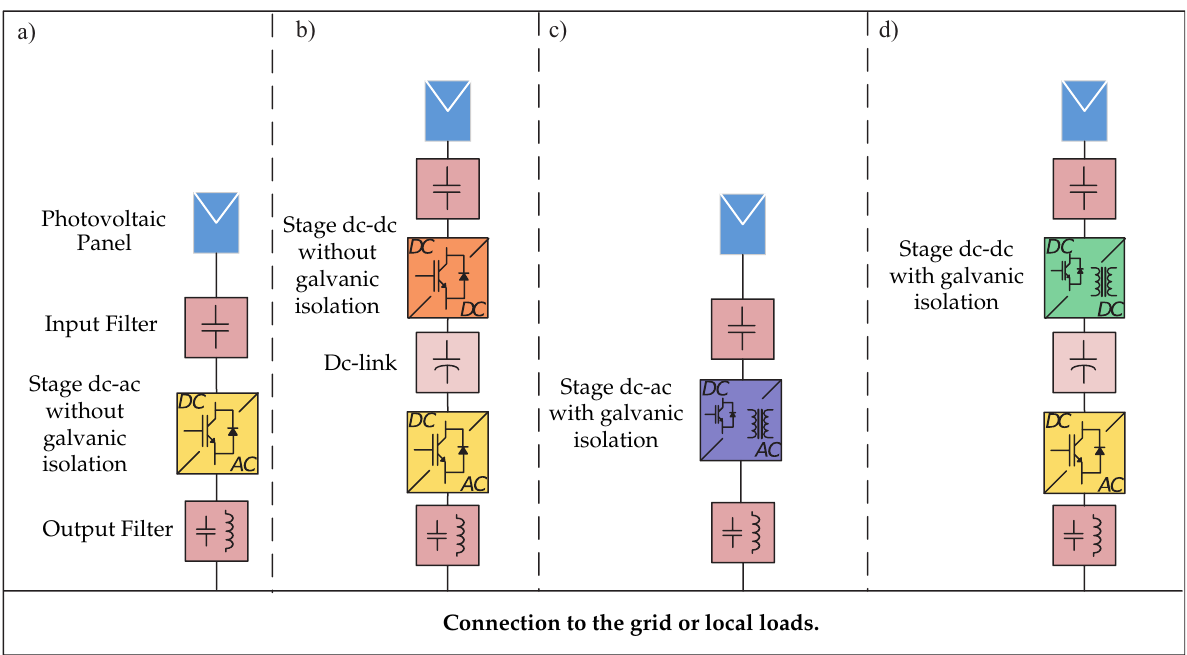
Figure 1. Classification of microinverters. ( a ) One-stage topology without galvanic isolation. ( b ) Two-stage topology with galvanic isolation. ( c ) One-stage topology with galvanic isolation. ( d ) Two-stage topology with galvanic isolation.